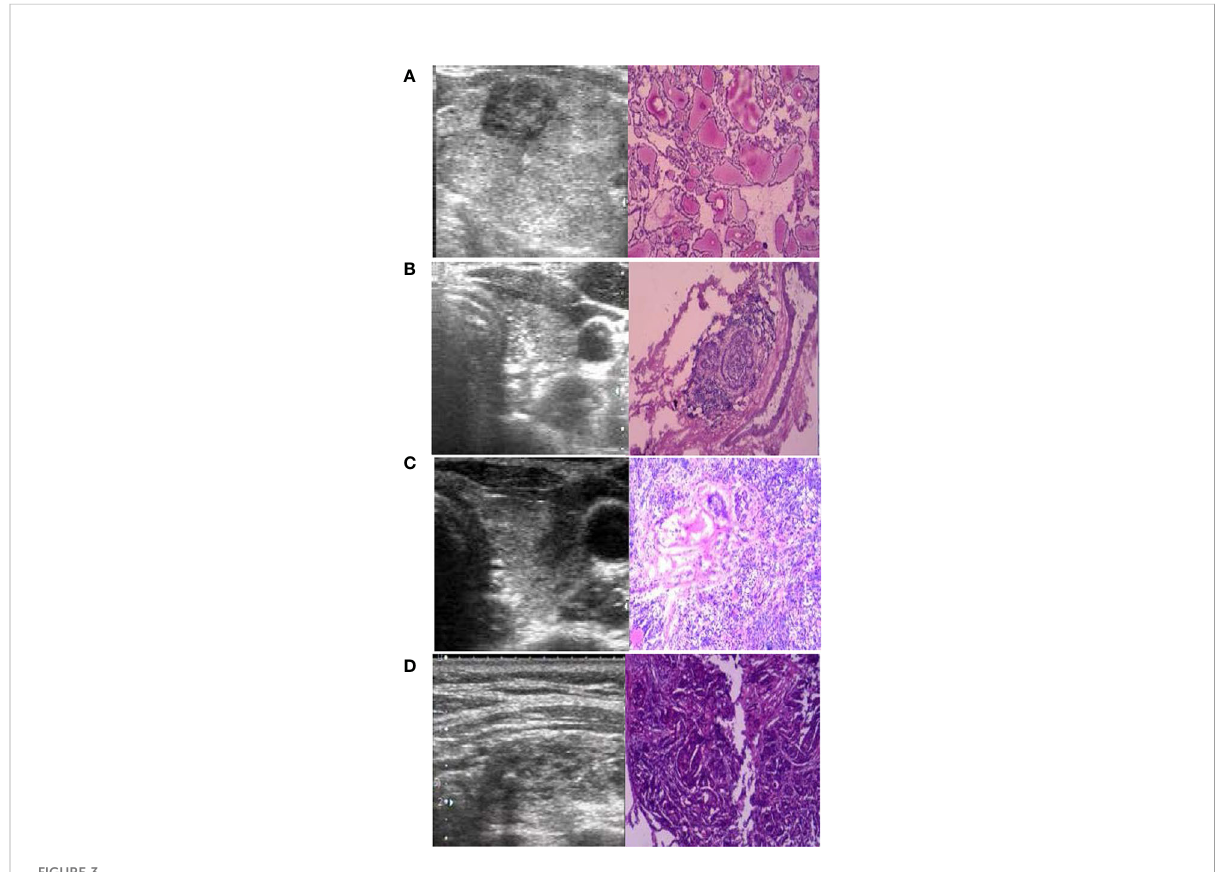
FIGURE 3 The preoperative ultrasound (US) and postoperative pathology (×100). (A) The ablation region had a new PTC four years after radiofrequency ablation (RFA). (B) The lymph nodes were metastasis (positive/all was 7/9) 3 months after RFA. (C) The PTC was not completely ablated 3 months after RFA. (D) The PTC was completely ablated 1 months after